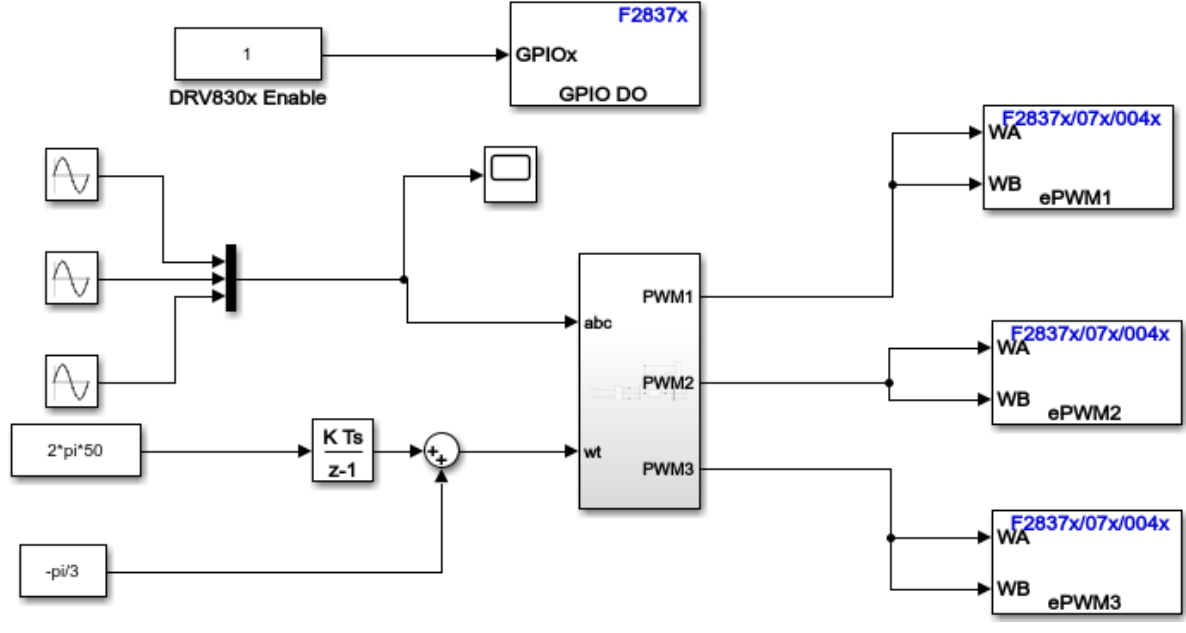
Figure 14. Example of a Matlab/Simulink program to control the asynchronous